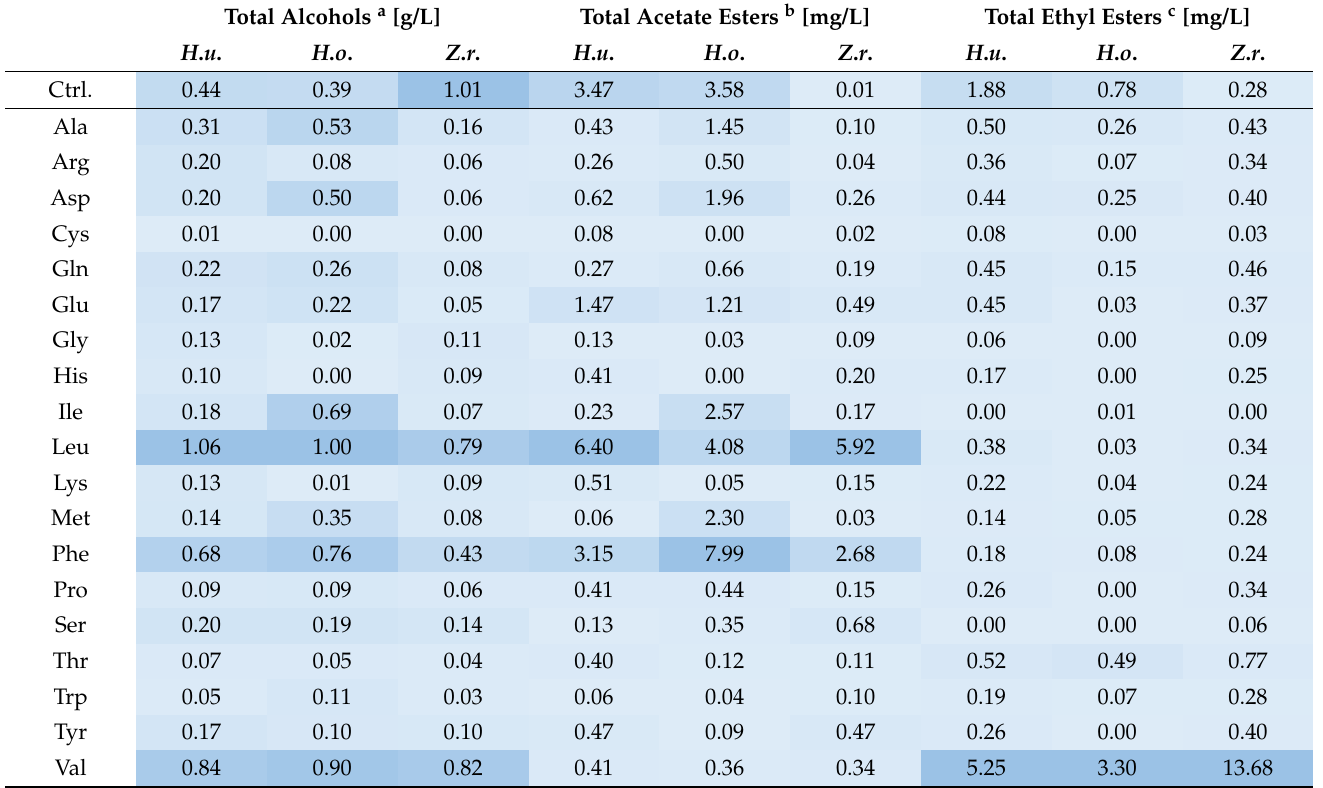
Table 5. Overview of the production of total alcohols, total acetate esters and total ethyl esters in the SM-AA fermentations. SM-mix (Ctrl.) and SM-AA fermentations using H. uvarum DSM2768 ( H . u .), H. osmophila NRRL Y-1613 T ( H . o .) and Z. rouxii GYBC-242 ( Z . r .). Darker colours indicate higher concentrations within the total alcohols, total acetate esters and total ethyl esters, lighter colours indicate lower concentrations within the respective group.